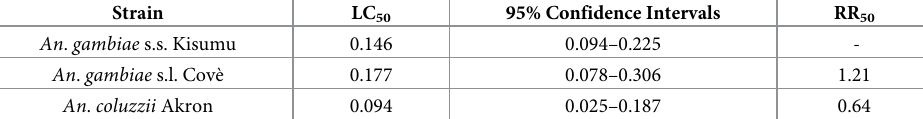
Table 2. Lethal concentrations (LC 50 ) and resistance ratios of An . gambiae s.l. Cov è , An . coluzzii Akron compared to An . gambiae s.s. Kisumu in bottle bioassays with broflanilide. Probit analysis was performed with 72h mortality data on mosquitoes exposed to bottles treated with broflanilide and Mero 1 applied at 800 ppm using SPSS software